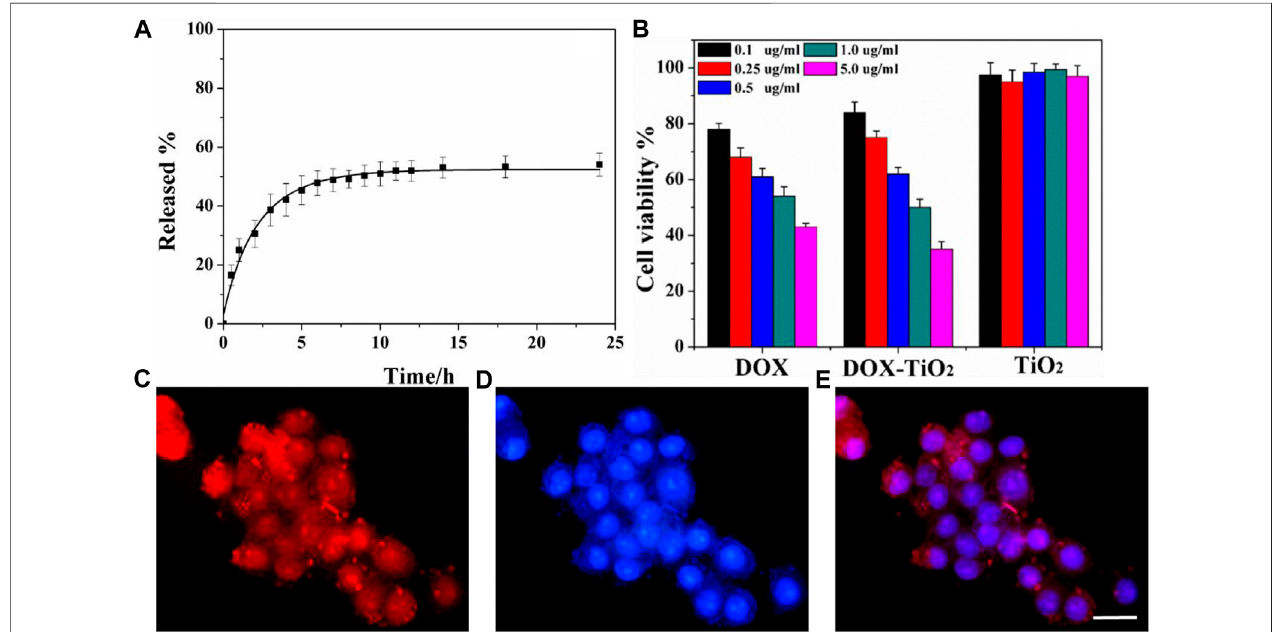
FIGURE 6 | (A) Drug-release pro fi le for DOX – TiO 2 in PBS buffer. (B) HeLa cells incubated with DOX, DOX – TiO 2, and TiO 2 . (C) Representative deconvolution microscope images ofHeLa cells treated with DOX – TiO 2 . Red fl uorescence arisesfrom DOX; Highlight red fl uorescence dot corresponds toDOX – TiO 2 ; (D) Nuclei were stained blue with Hoechst 33342; (E) Merged image of Hoechst, DOX, and DOX – TiO 2 signals. Scale bars is 20 μ m.